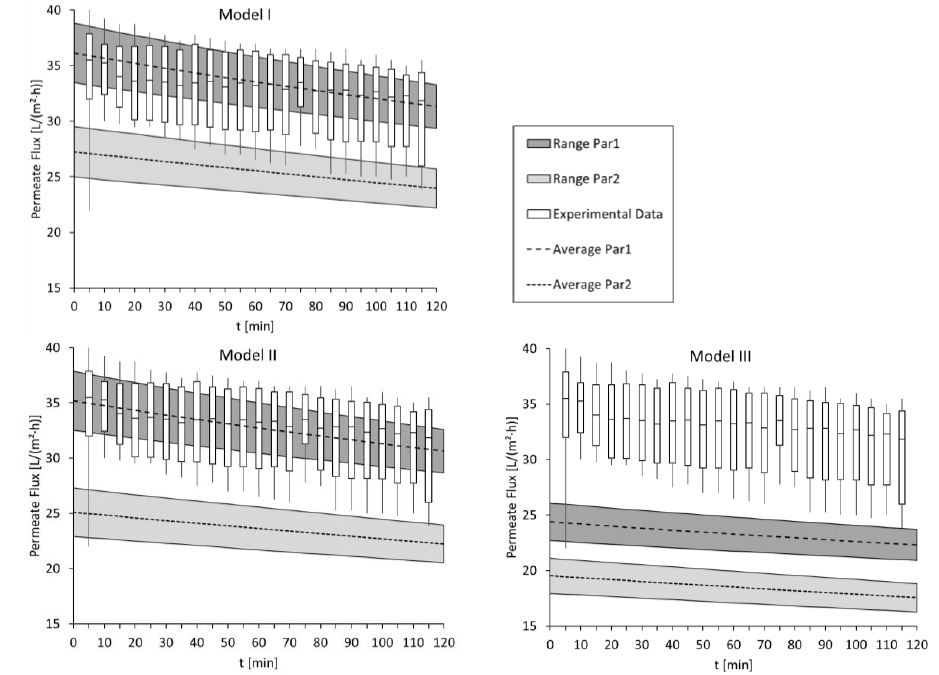
Figure 2. Modelled and experimental permeate fluxes of membrane performance tests.